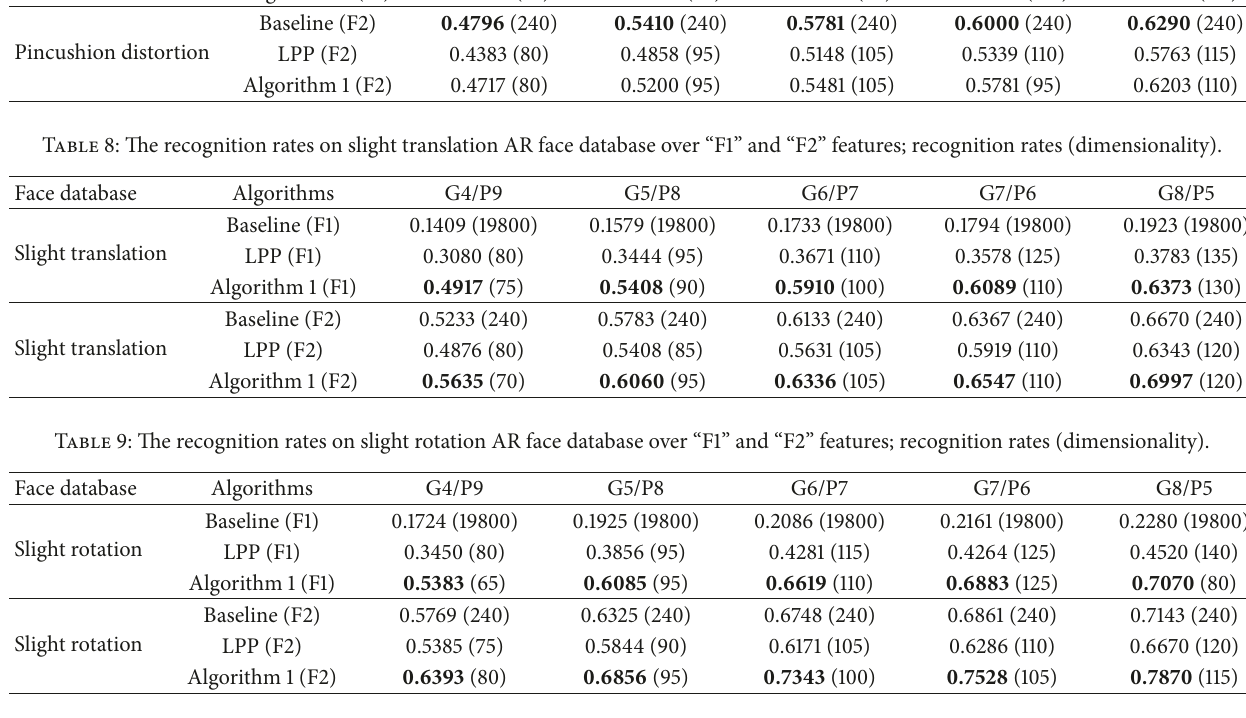
Table 10: The recognition rates on subAR face database over “F3” features; recognition rates (dimensionality).